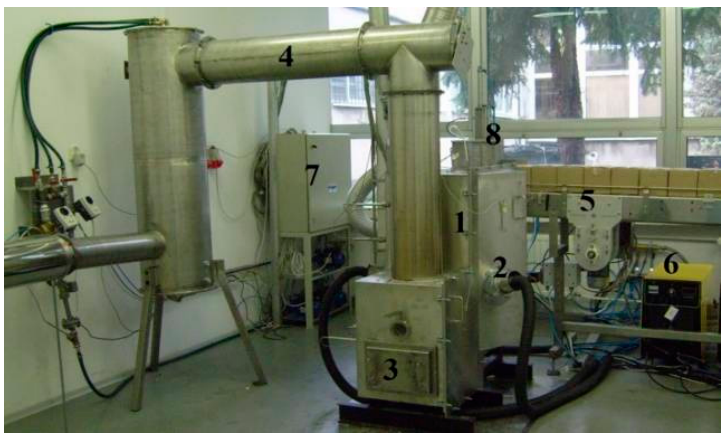
Figure 2. Overview of the laboratory setup: (1) plasma reactor; (2) plasmatron; (3) molten product collection; (4) fumes exhaust–chimney; (5) waste package transporter; (6) plasmatron power supply; (7) PLC-automation and data collection apparatus cabinet; (8) automatic waste package feeder.